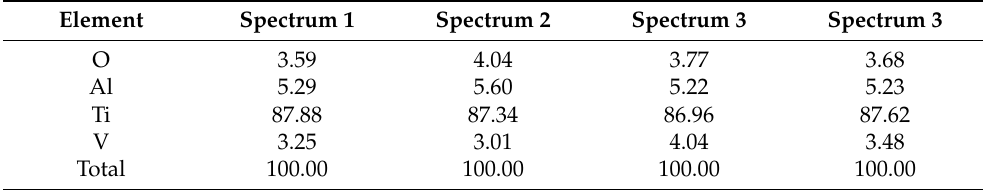
Table 4. Elemental composition on different spots (position 1–4) on surface Ti-6Al-4V alloy after potentiodynamic polarization measurements in PBS